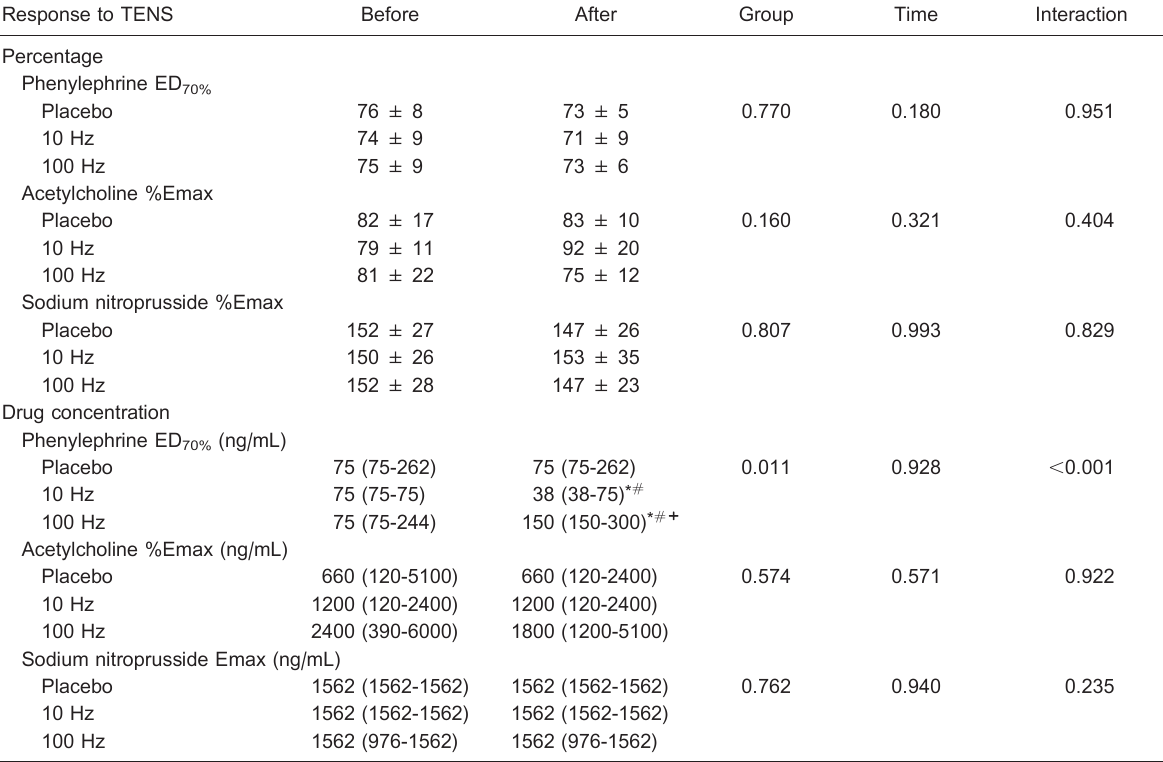
Table 2. Venoconstriction (phenylephrine) and endothelium-dependent (acetylcholine) and endothelium-independent (sodium nitroprusside) venodilation in percentage and drug concentrations. Response to TENS